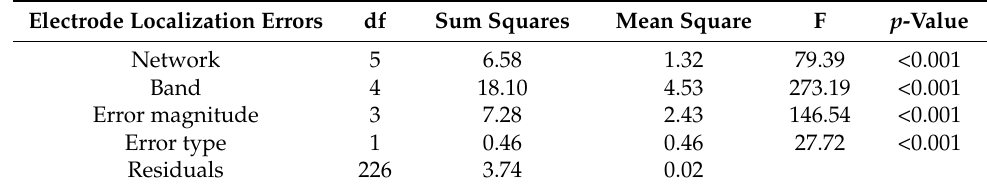
Table 1. ANOVA testing for electrode localization errors. Four factors were assessed: resting-state network (DMN, DAN, VAN, LN, SMN and VN), frequency band (delta; theta; alpha; beta; gamma), error magnitude (0.25; 0.5; 0.75; 1 cm) and error type (systematic; random). Electrode Localization Errors